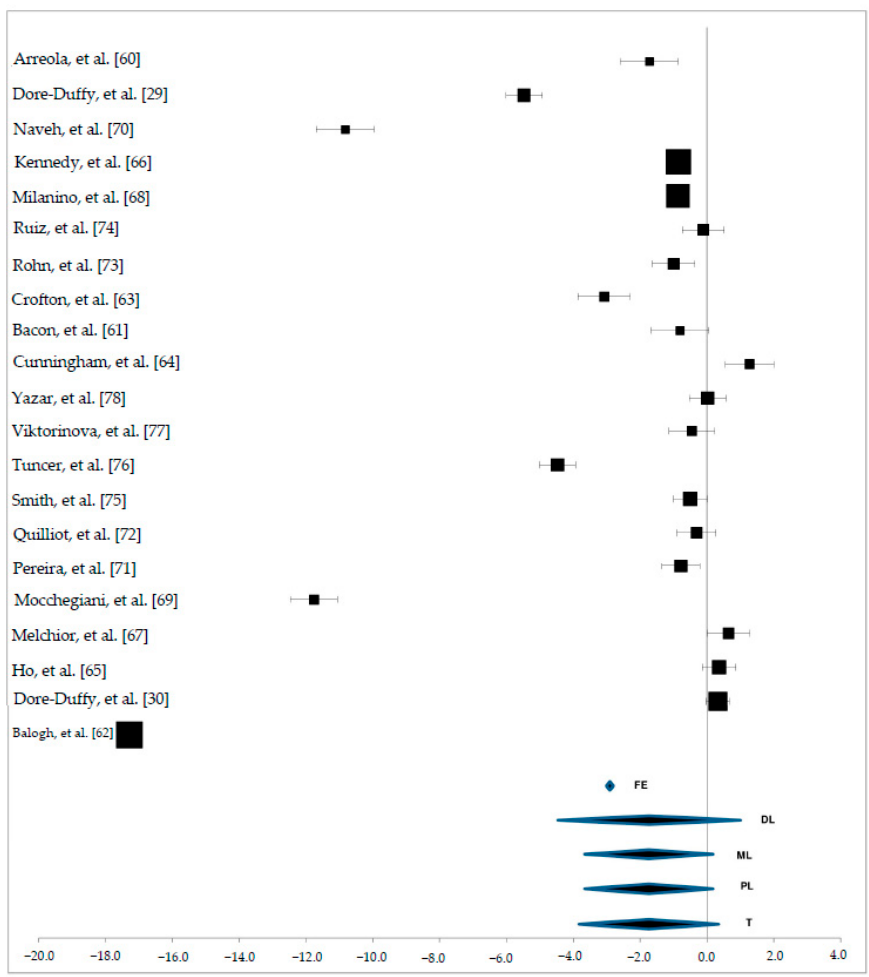
Figure 3. Forest plot of zinc status in plasma samples. Nutrients 2018 , 10 , 68